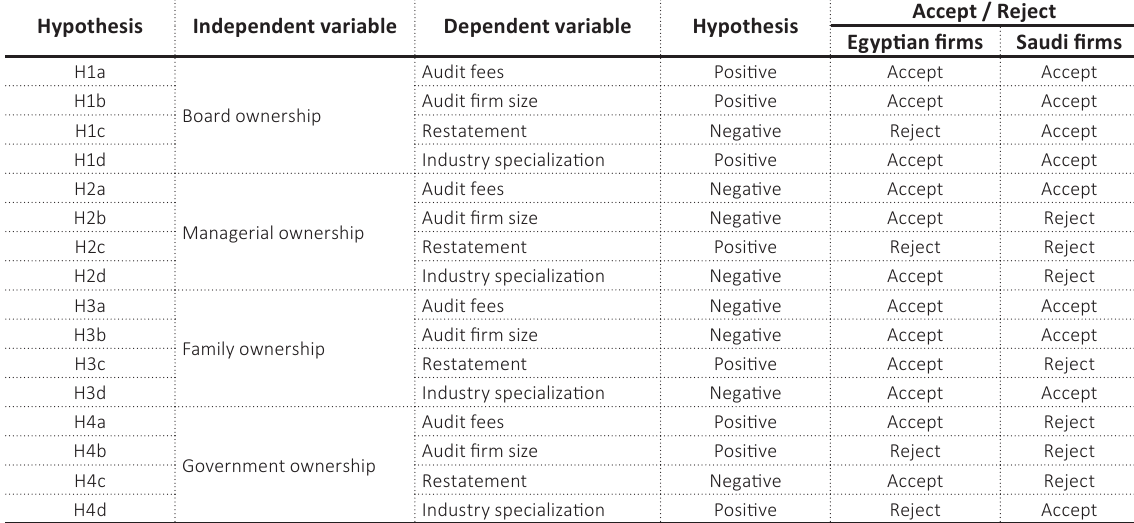
Table 10. Summary of the study’s hypotheses testing results